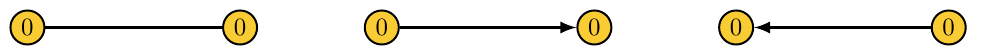
Figure 11. The periodic quiver for C 2 and its perfect matchings, represented here as orientations of the